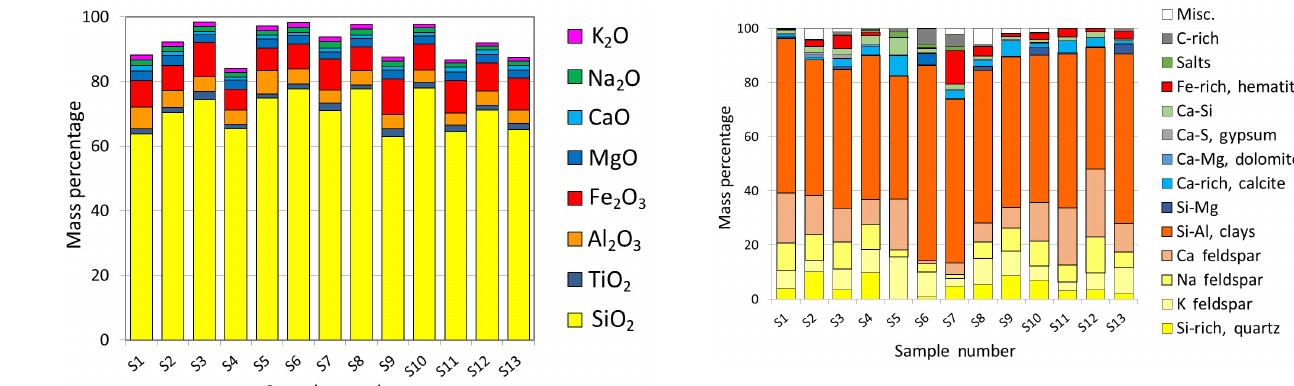
Figure 5. CCSEM-based individual particle analysis for the 0.5– 38µm chemical set, with the chemical bins labeled as minerals, ar- ranged by normalized mass